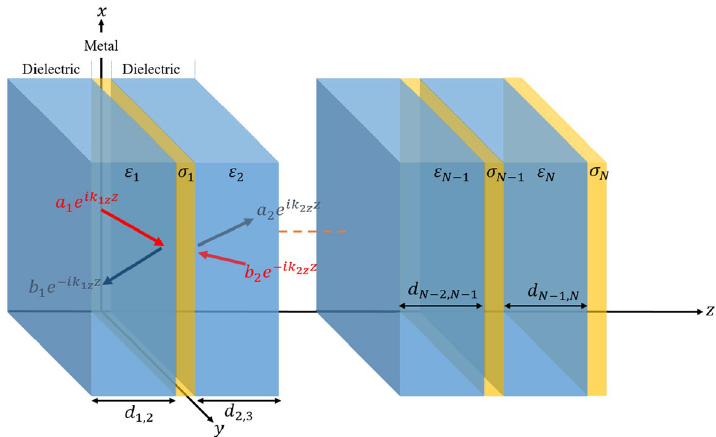
Figure 13. A thin metal layer with σ conductivity surrounded by two dielectric layers with values ε 1 and ε 2 . The structure is self-repeatable and can be reduced to a DMD structure for a single metal layer. Red and blue arrows represent the electromagnetic wave at the interface and at the reflected,